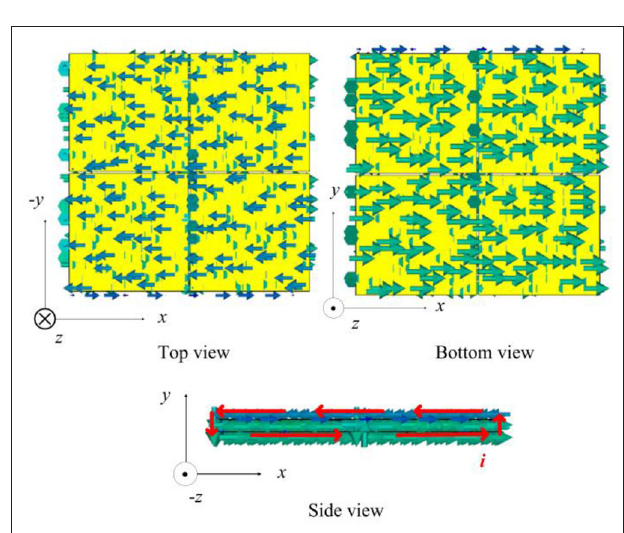
FIGURE 4 | The surface current distributions on the surface of